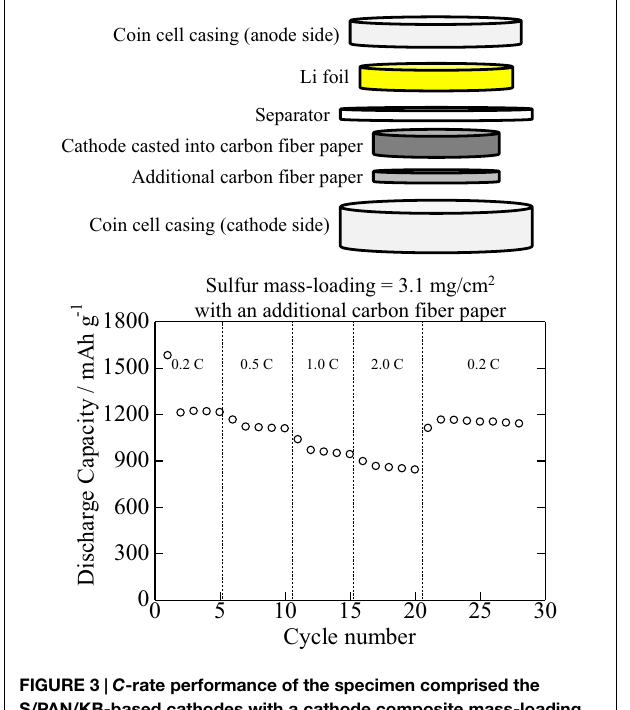
FIGURE 3 | C -rate performance of the specimen comprised the S/PAN/KB-based cathodes with a cathode composite mass-loading of 8.1mg/cm 2 (sulfur, 3.1mg/cm 2 ; carbon fiber paper, 300 µ m thick) that was cast into carbon fiber papers, and lithium foils as anodes . A 100- µ m-thick additional carbon fiber paper was inserted between a current-collecting coin cell casing (cathode side) and the cathode.